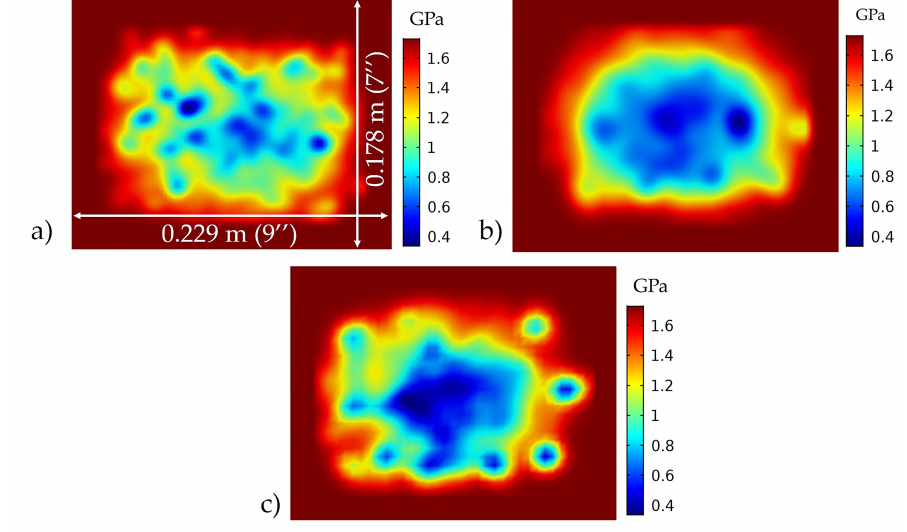
Figure 8. Spatially varying Young’s modulus obtained from image analysis for ( a ) sample 1, ( b ) sample 2, ( c ) sample